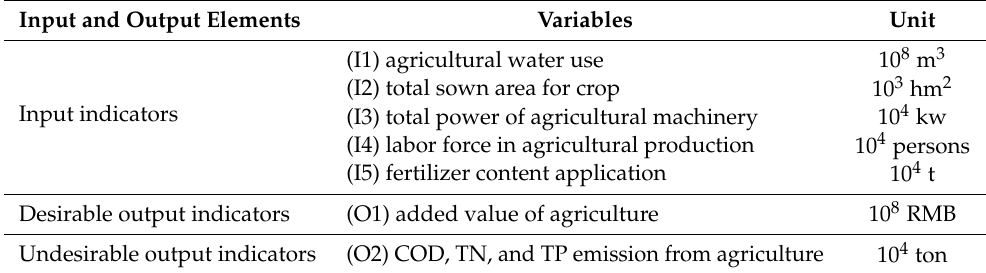
Table 1. Input and output indicators in the assessment of agricultural water use efficiency.